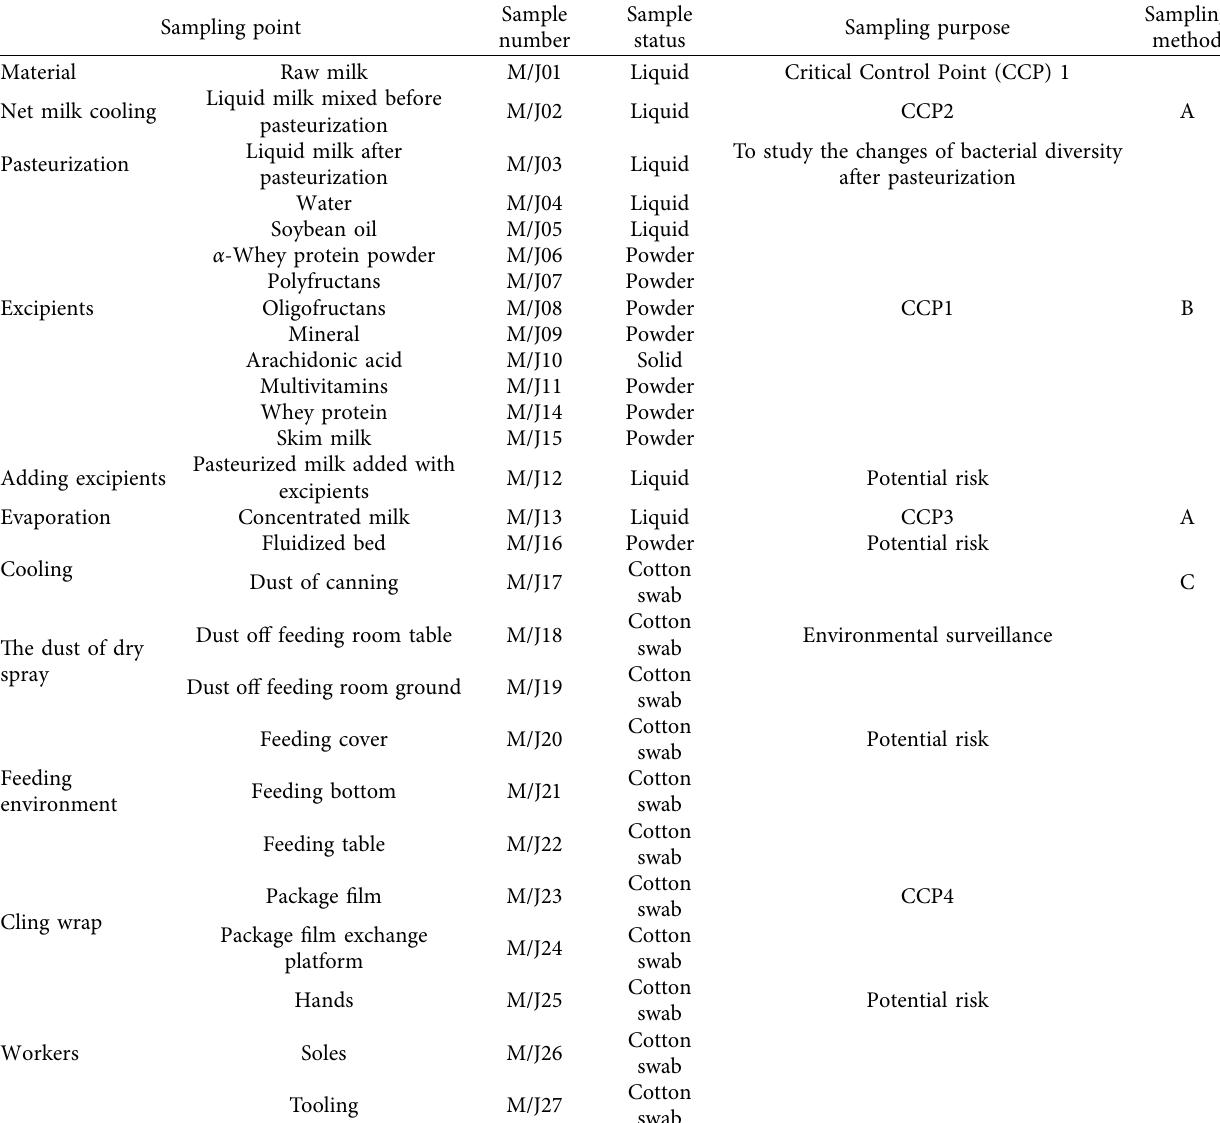
Table 1: List of sampling points in the infant milk formula production